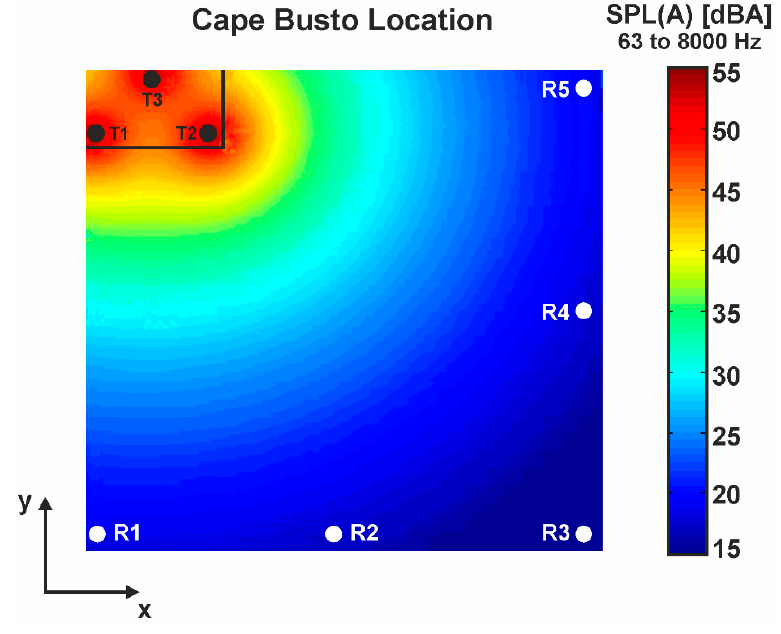
Figure 7. Noise map (dBA) in the Cape Busto scenario.